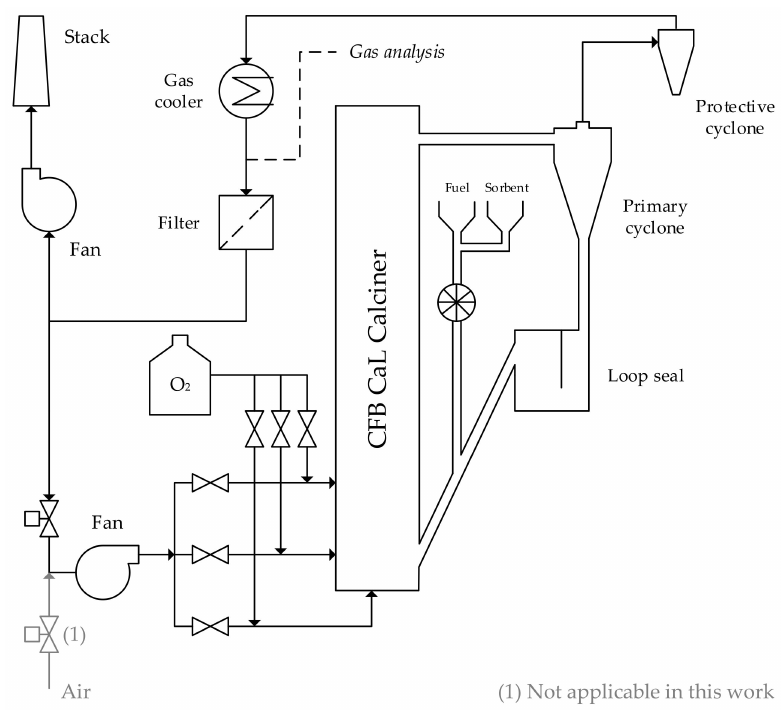
Figure 2. Schematic of the 200 kW th Calcium Looping